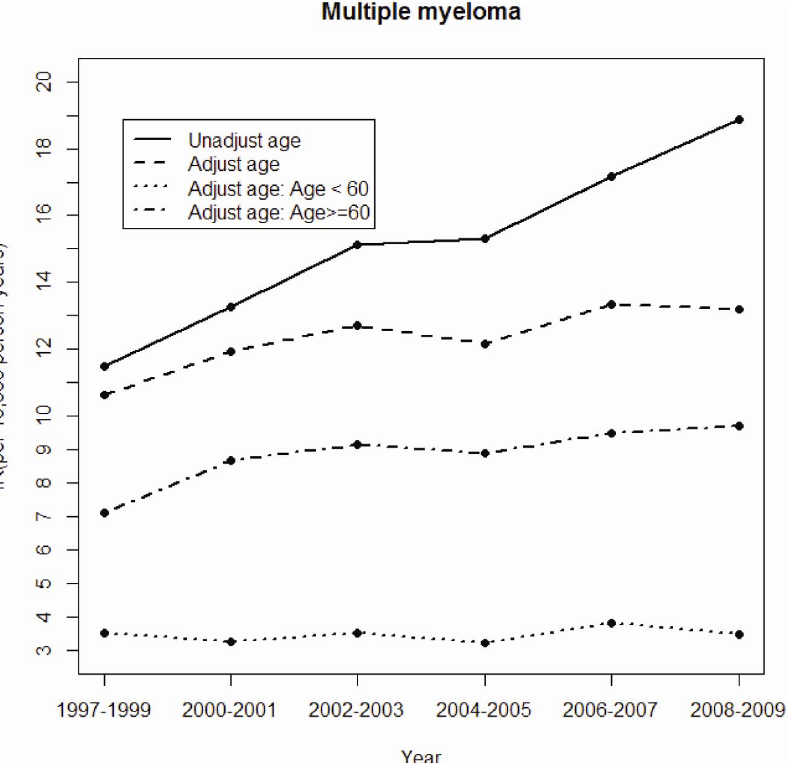
Figure 2. Unadjusted and adjusted overall incidence rates and age-specific adjusted incidence of multiple myeloma for the period of 1997–2009.